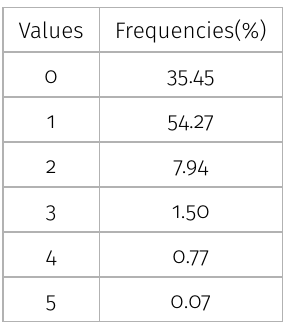
Table I. DIT in system category. Table II. DIT in system category.